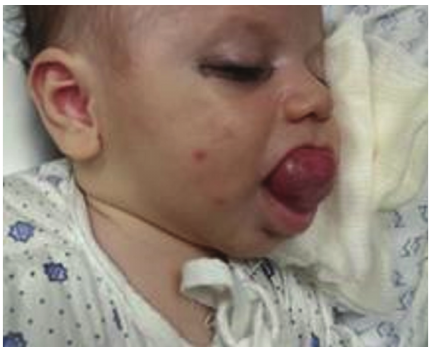
Figure 1: Large protruded tongue, showing a swelling in the floor of the mouth.